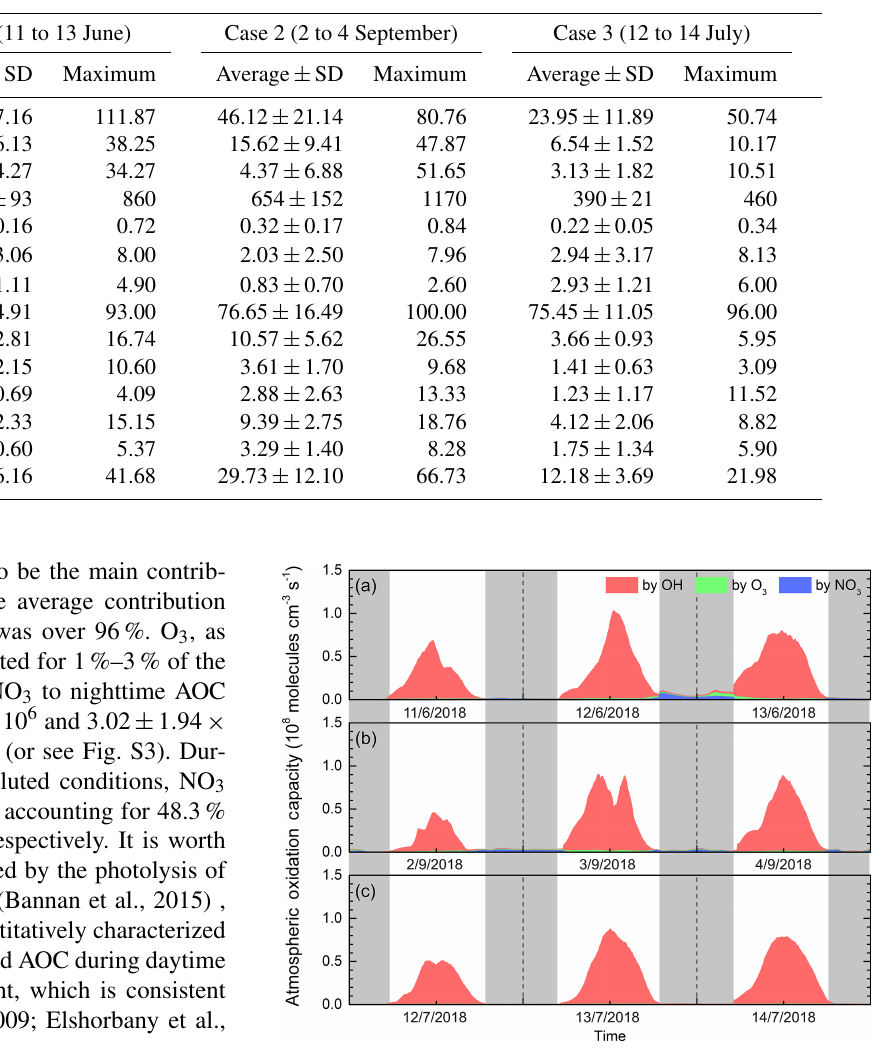
Table 1. Summary of pollutant mixing ratios (unit: ppbv) and meteorological parameters for three cases of different ozone levels.